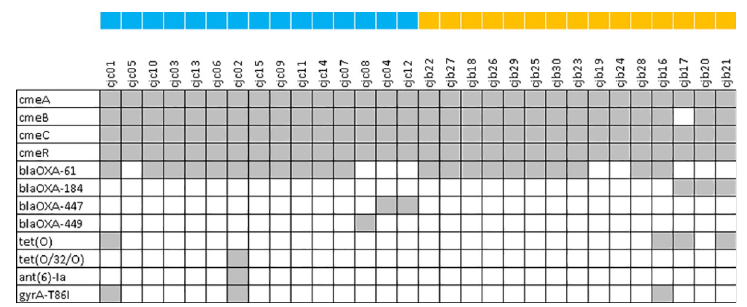
Fig 5. Prevalence (grey = absent, white = present) of antimicrobial resistance determinants in clinical and broiler isolates. Blue squares were placed beside clinical and orange squares were placed beside broiler isolates.